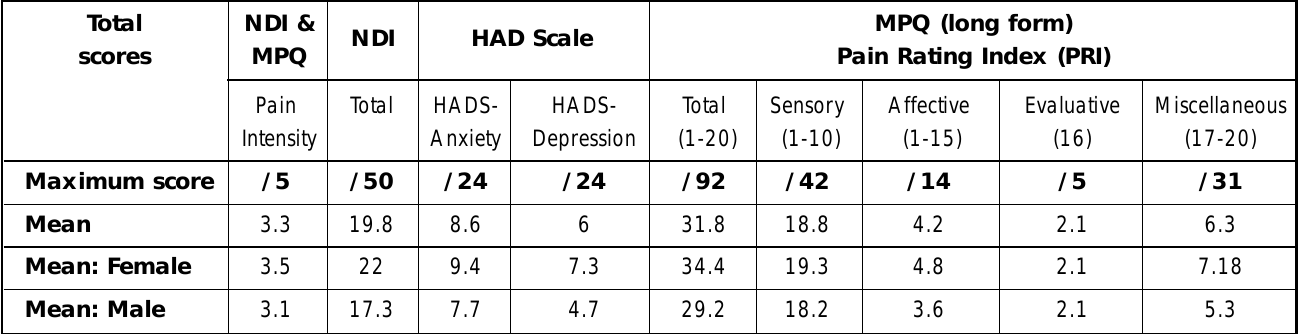
Table 1: Composite mean scores obtained by 21 subjects for pain intensity, total NDI, HAD-A and HADS-D subscales, PRI scores for each categories and total PRI of MPQ (long form).